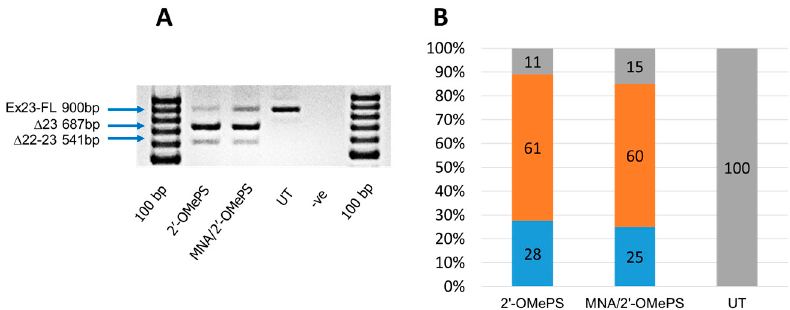
Figure 3. RT-PCR analysis ( A ) and densitometry analysis ( B ) of exon 23 skipping in cultured mdx myotubes. Orange colour: Percentage of exon-skipping product. Blue colour: Percentage of dual exon-22/23 skipped product. Grey colour: Percentage of full length product. UT: Untreated.